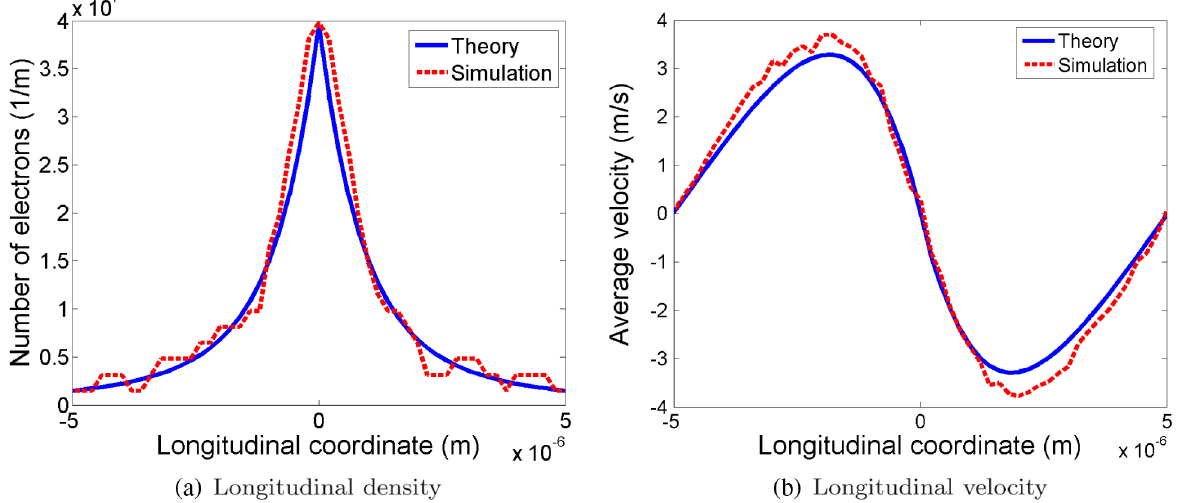
FIG. 3. Comparison of theory and numerical simulations of density (a) and velocity (b) modulation by stationary ion with respect to uniform electron